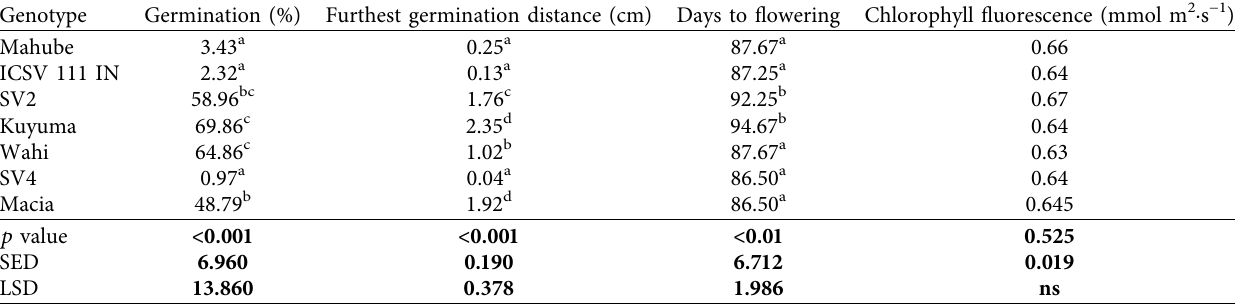
Table 4: Effect of strigolactones produced by different sorghum genotypes on S. asiatica germination percentage and furthest germination distance.